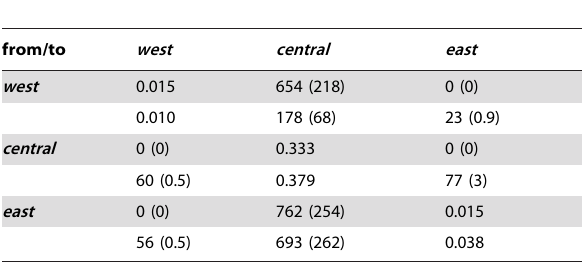
Table 5. Migration matrix of the two most supported gene flow models in the Northern Indian Ocean sister-species (M 3 and M 1 ; Fig. 2).